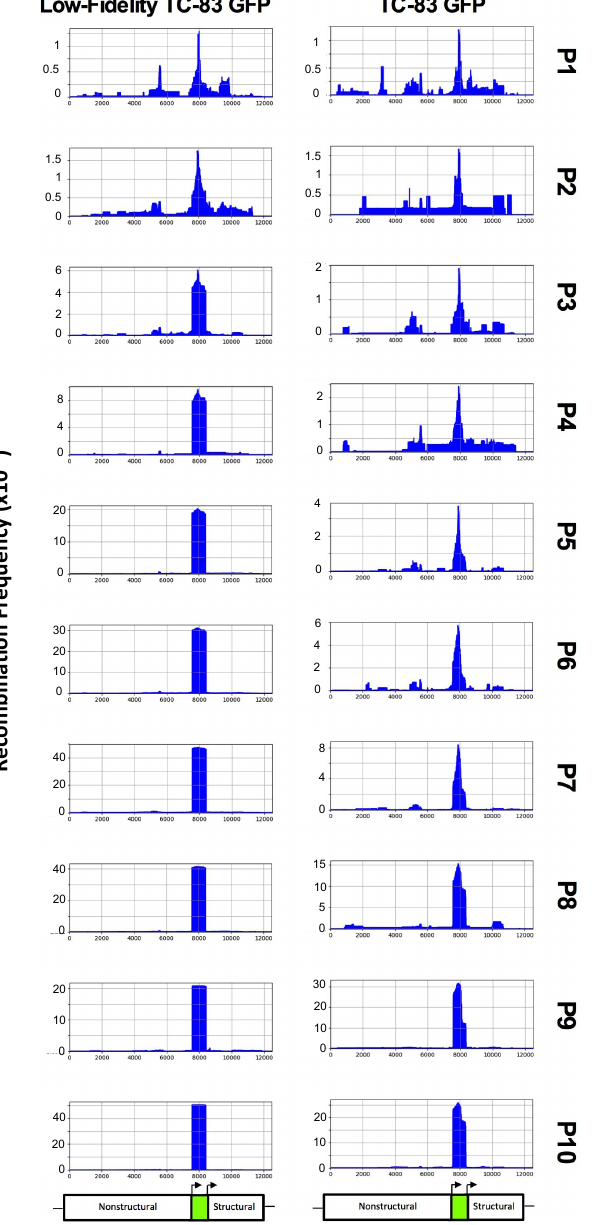
Figure 3. ViReMa recombination results for TC-83 GFP and low-fidelity TC-83 GFP. Each passage of the first replicate of TC-83 GFP and low-fidelity TC-83 GFP was sequenced using ClickSeq libraries and analyzed using ViReMa. The x -axis shows genome position, while the y -axis shows the recombination frequency (i.e., normalized to the total reads that map to low-fidelity TC-83 GFP). Below the recombination charts, a schematic shows the approximate location of the nonstructural protein, GFP, and structural genes. “P” represents